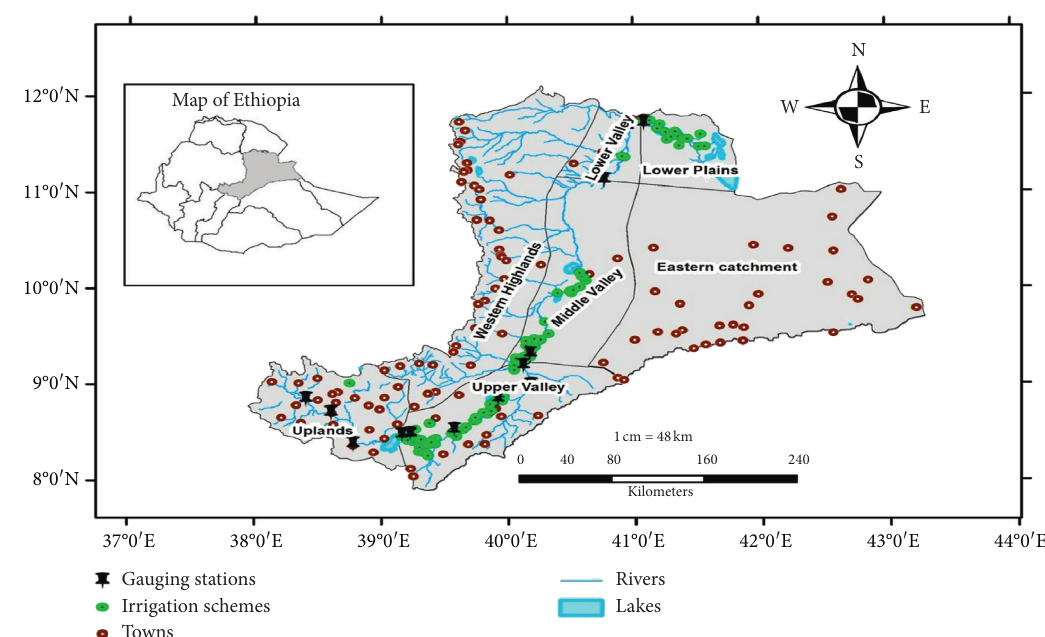
Figure 1: Map showing routes of the Awash